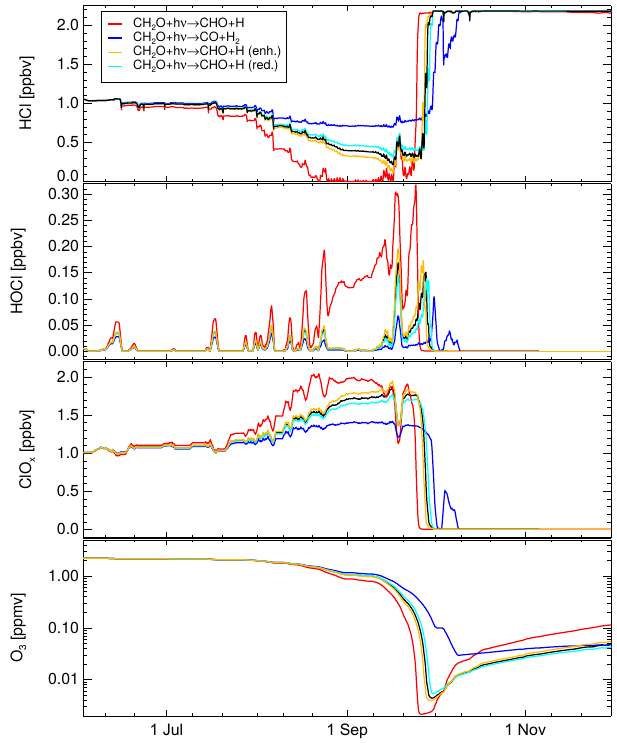
Figure 2. Sensitivity of the ozone hole chemistry on HO 2 produc- tion in the photolysis of CH 2 O. The black line shows the reference case, the red line a case assuming 100% efficiency for HO 2 produc- tion (i.e. for Reaction R14), and the dark blue line a case assuming no HO 2 production in the photolysis of CH 2 O (100% efficiency for Reaction R22). The light blue and the yellow line show a more re- alistic estimate of the kinetic uncertainties, namely branching ratio for the radical channel enhanced by 20% (yellow line) and reduced by 20% (light blue